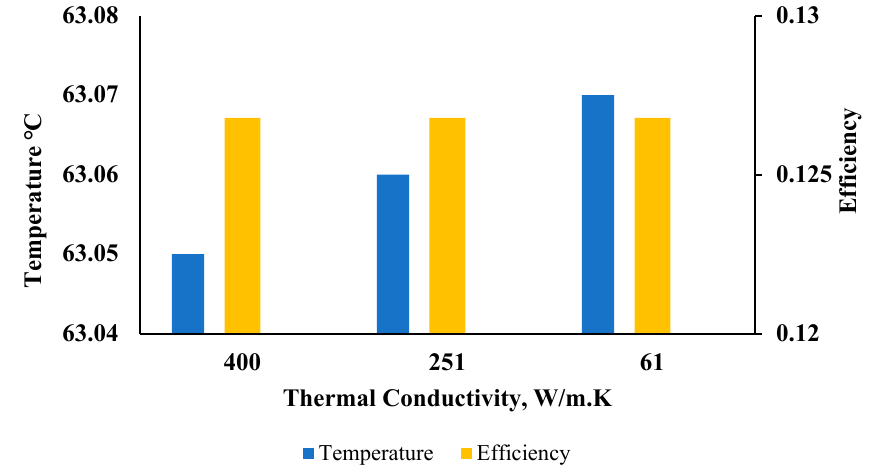
Figure 9. Effect of heat pipe material on panel temperature and efficiency .